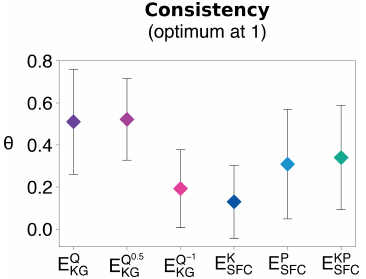
Figure 7. Comparison of the consistency of the set of behavioural parameter sets identified with the six objective functions across the 14 split-sample tests (described in Sect.